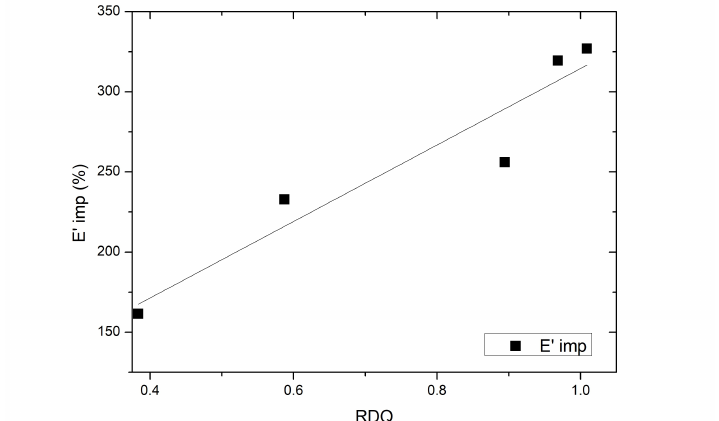
Figure 8. A development of storage modulus of CNT/NBR nanocomposites as a function of relative dispersion quality for untreated and treated films.